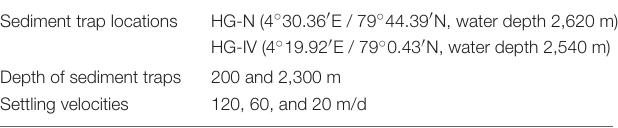
TABLE 1 | Settings of 12 experiments performed in this study. Sediment trap